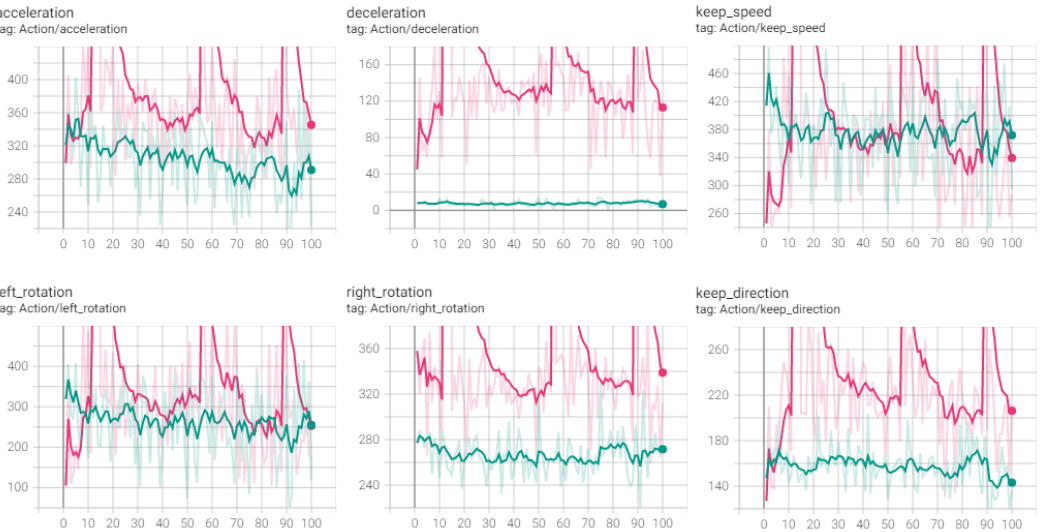
Figure 11. Action of the autonomous ship. The ship is controlled by [acceleration/deceleration] and [steering]. Random and ILFAS RL are shown in red and green, respectively. The graph shows the number of controls of steering and speed in the same environment. It also indicates the stability in autonomous ship control. ILFAS (Green) is narrow range of Actions value than Random (Red).